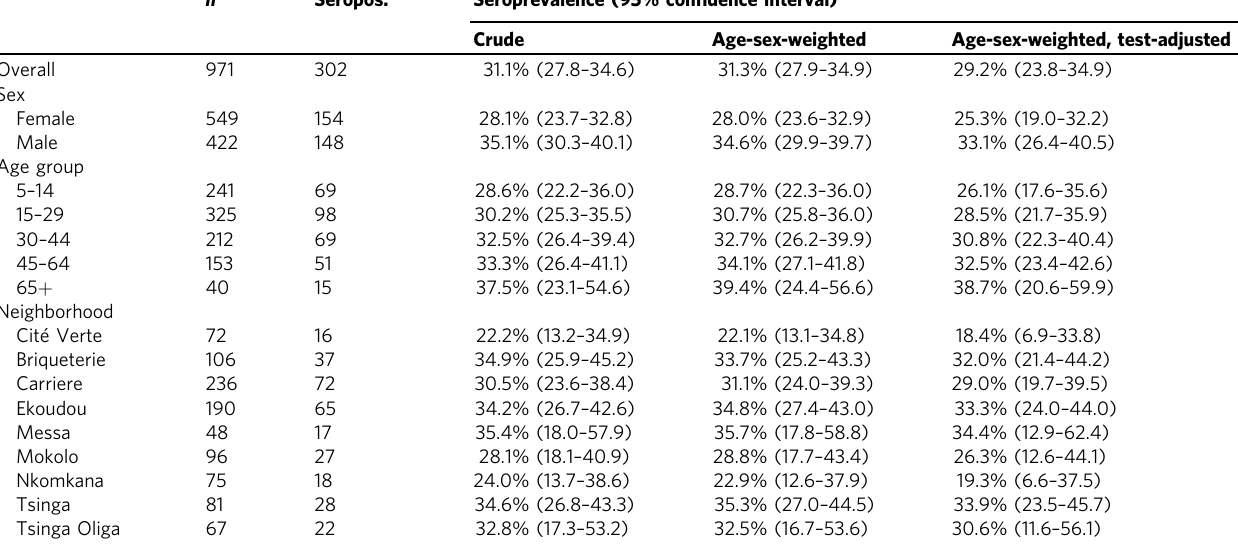
Table 2 Age-sex weighted and test-adjusted seroprevalence estimates for anti-SARS-CoV-2 IgG antibodies.